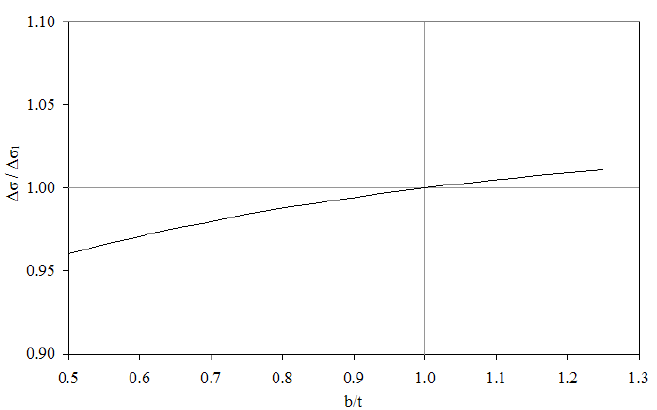
Figura 2: Variazione prevedibile della resistenza a fatica  σ a parità di numero di cicli n al variare dello spessore b del cordone di saldatura, per T/t = 3. Valore di riferimento  σ 1 relativo al caso b/t = 1. Saldatura a completa penetrazione.